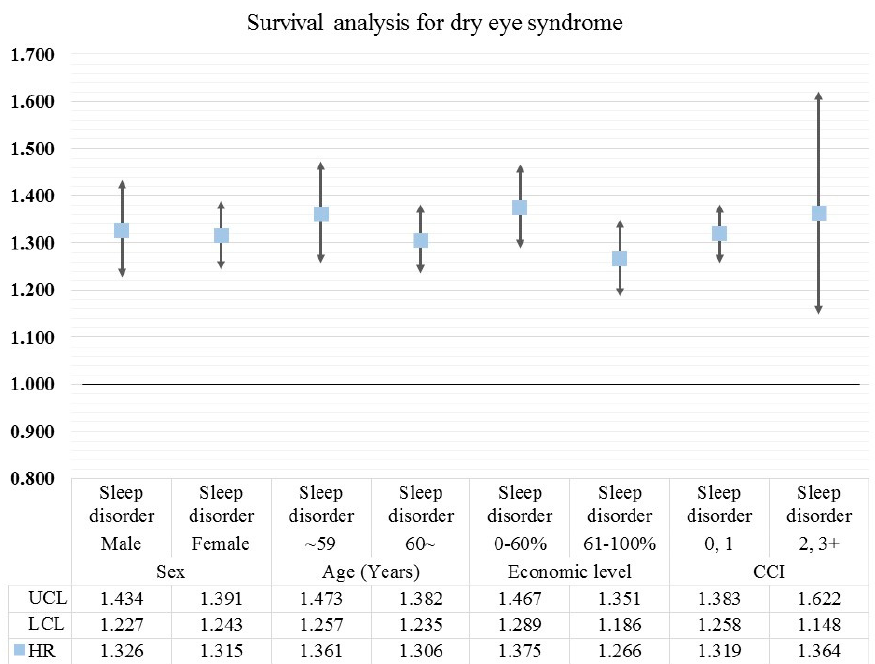
Figure 2. The results of sub ‐ group analysis for survival analysis according to sex, age, economic level, and CCI. The HR as marked by the square points was calculated by survival analysis to investigate the association between sleep disorder and DES. Results were considered statistically significant if each bar marked to SD did not reach the cut ‐ off line of 1.000.